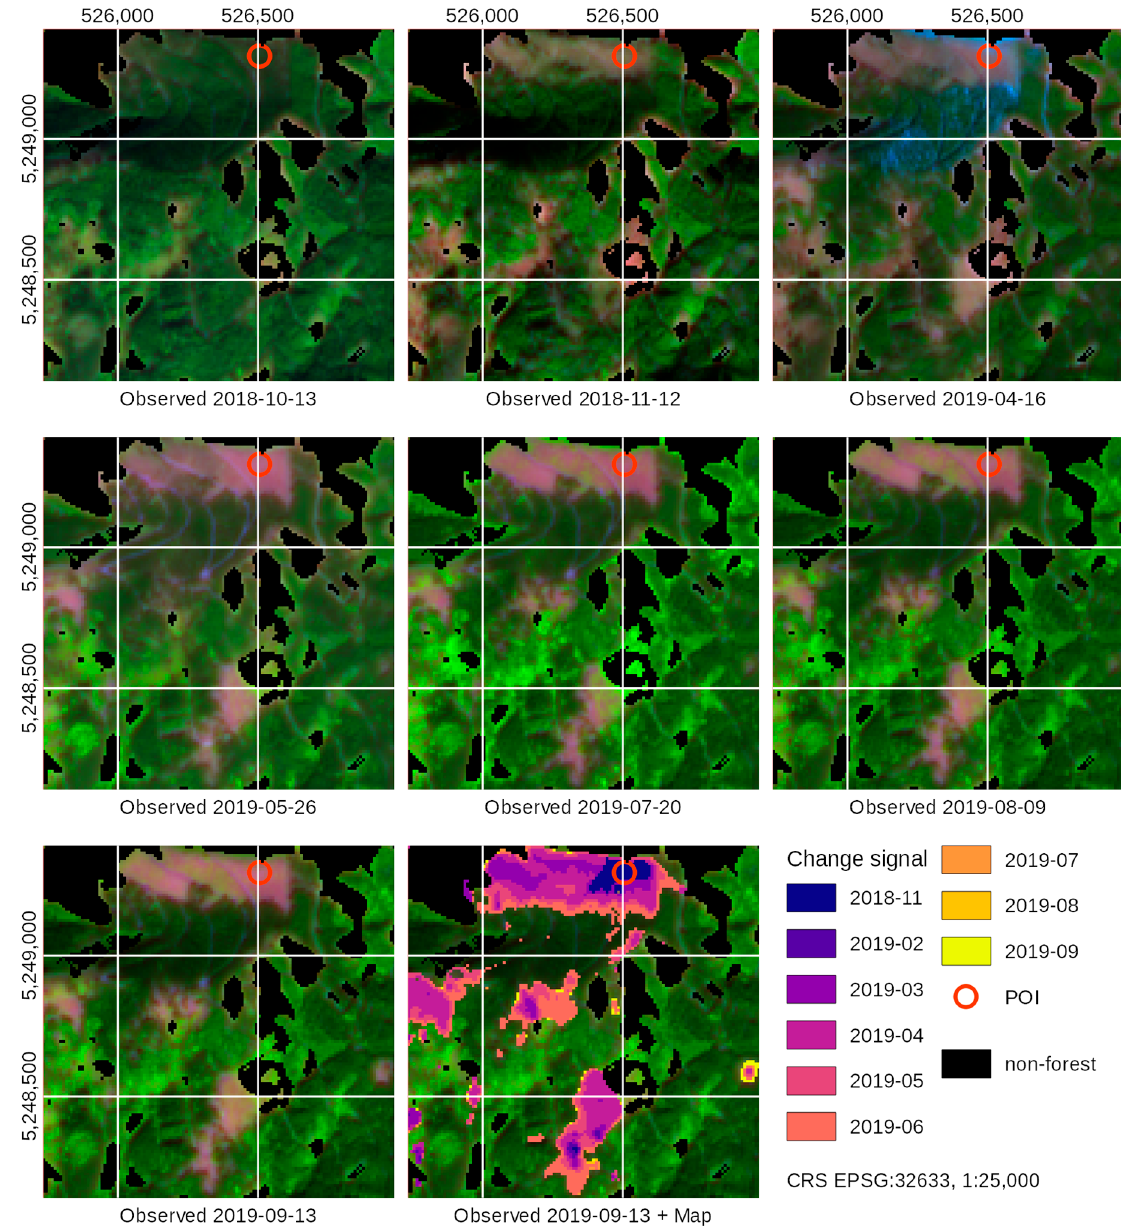
Figure 5. Examples of near real-time forest change detection in Austria. Storm “Vaia” windthrows on 29/30 October 2018 at an alpine forest site in Styria (~1400 m above sea level).